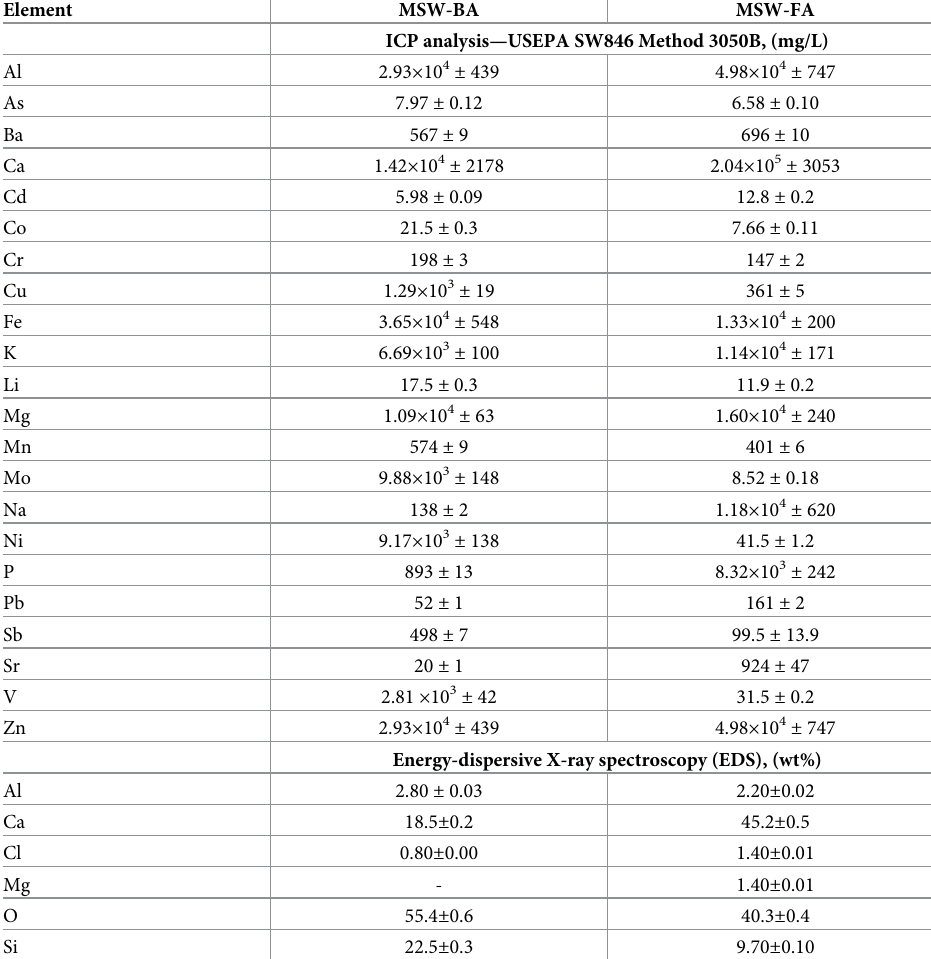
Table 2. Elemental compositions of the MSW-BA and the MSW-FA according to USEPA SW846 Method 3050B and Energy-dispersive X-ray spectroscopy (EDS).